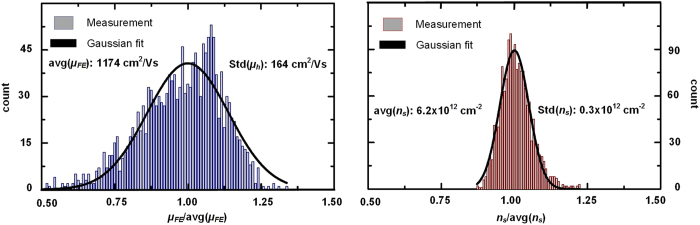
Histograms with measured μhole and ns,hole within the dashed, black rectangles Fig. 2 in (d) and (e).